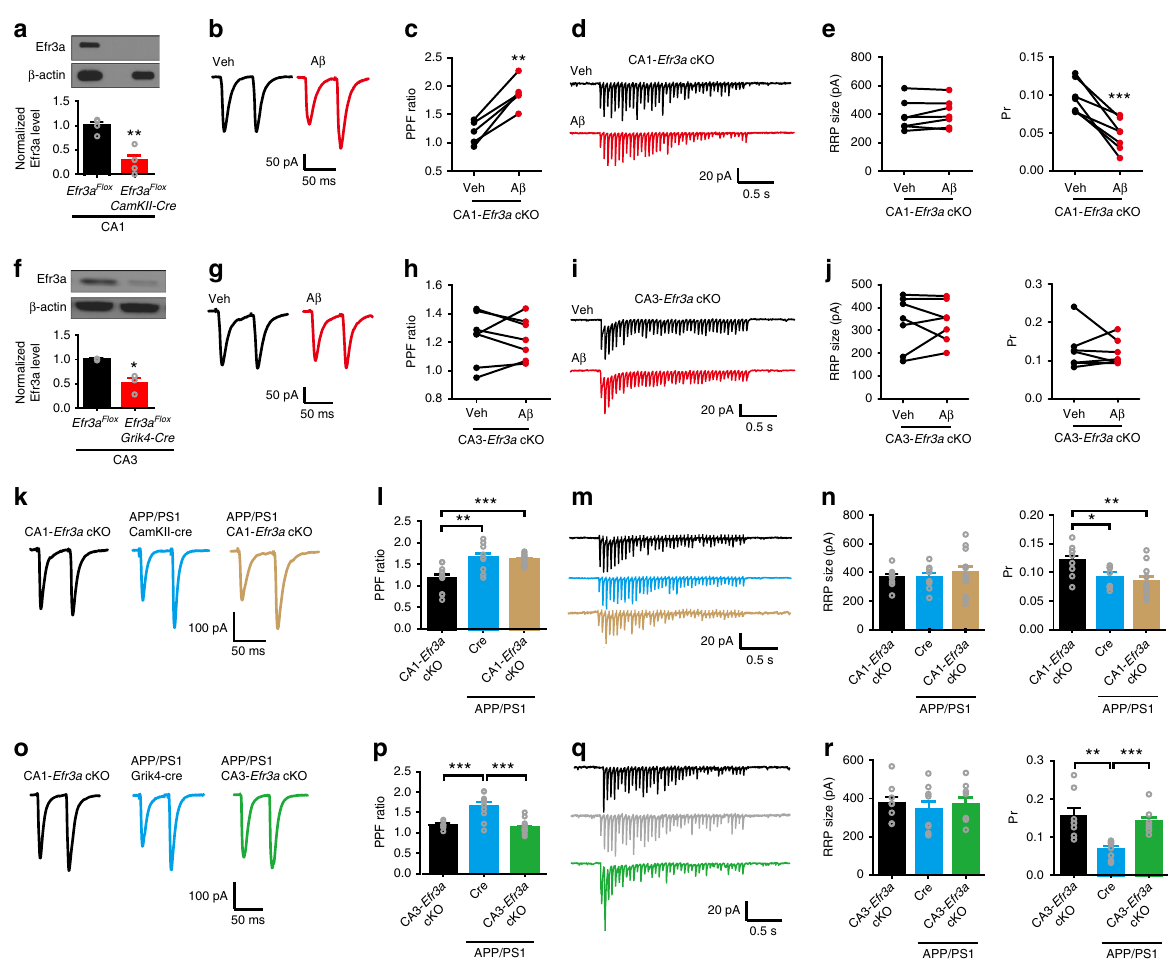
Fig. 8 Selectively knocking out Efr3a in the CA3 area prevents oligomeric A β -induced inhibition of presynaptic release probability at the SC-CA1 synapse. a – j Representative traces of PPF ( b , CA1- Efr3a cKO mice; g , CA3- Efr3a cKO mice) and 20 Hz train responses ( d , CA1- Efr3a cKO mice; i , CA3- Efr3a cKO mice) and quanti fi cation of PPF ratio ( c , CA1- Efr3a cKO mice; h , CA3- Efr3a cKO mice), RRP size ( e , CA1- Efr3a cKO mice; j , CA3- Efr3a cKO mice; left), and Pr ( e , CA1- Efr3a cKO mice; j , CA3- Efr3a cKO mice; right) at the SC-CA1 synapse showing oligomeric A β (400 nM) increases Pr in CA1- Efr3a cKO mice (immunoblotting and quanti fi cation of Efr3a in CA1 shown in a ), whereas oligomeric A β no longer changes Pr in CA3- Efr3a cKO mice (immunoblotting and quanti fi cation of Efr3a in CA3 shown in f ). t test; * P < 0.05; ** P < 0.01; *** P < 0.001; N = 3 – 7 per group. k – r Representative traces of PPF ( k , APP/PS1 CA1- Efr3a cKO and control mice; o , APP/PS1 CA3- Efr3a cKO and control mice) and 20 Hz train responses ( m , APP/PS1 CA1- Efr3a cKO and control mice; q , APP/PS1 CA3- Efr3a cKO and control mice) and quanti fi cation of PPF ratio ( l , APP/PS1 CA1- Efr3a cKO and control mice; p , APP/PS1 CA3- Efr3a cKO and mice), RRP size ( n , APP/PS1 CA1- Efr3a cKO and control mice; r , APP/PS1 CA3- Efr3a cKO and control mice; left), and Pr ( n , APP/PS1 CA1- Efr3a cKO and control mice; r , APP/PS1 CA3- Efr3a cKO and mice; right) at the SC-CA1 synapse showing selectively knocking out Efr3a in the CA3 area restores the decreased Pr in APP/PS1 mice. One-way ANOVA with post hoc Dunnett ’ s test; F (2,29) = 11.38 ( l ); F (2,31) = 20.66 ( p ); F (2,26) = 0.28 ( n , left); F (2,26) = 5.99 ( n , right); F (2,21) = 0.986 ( r , left); F (2,21) = 0.19 ( r , right); * P < 0.05; ** P < 0.01; *** P < 0.001; N = 8 – 15 per group. Data are mean ± SEM. Source data are